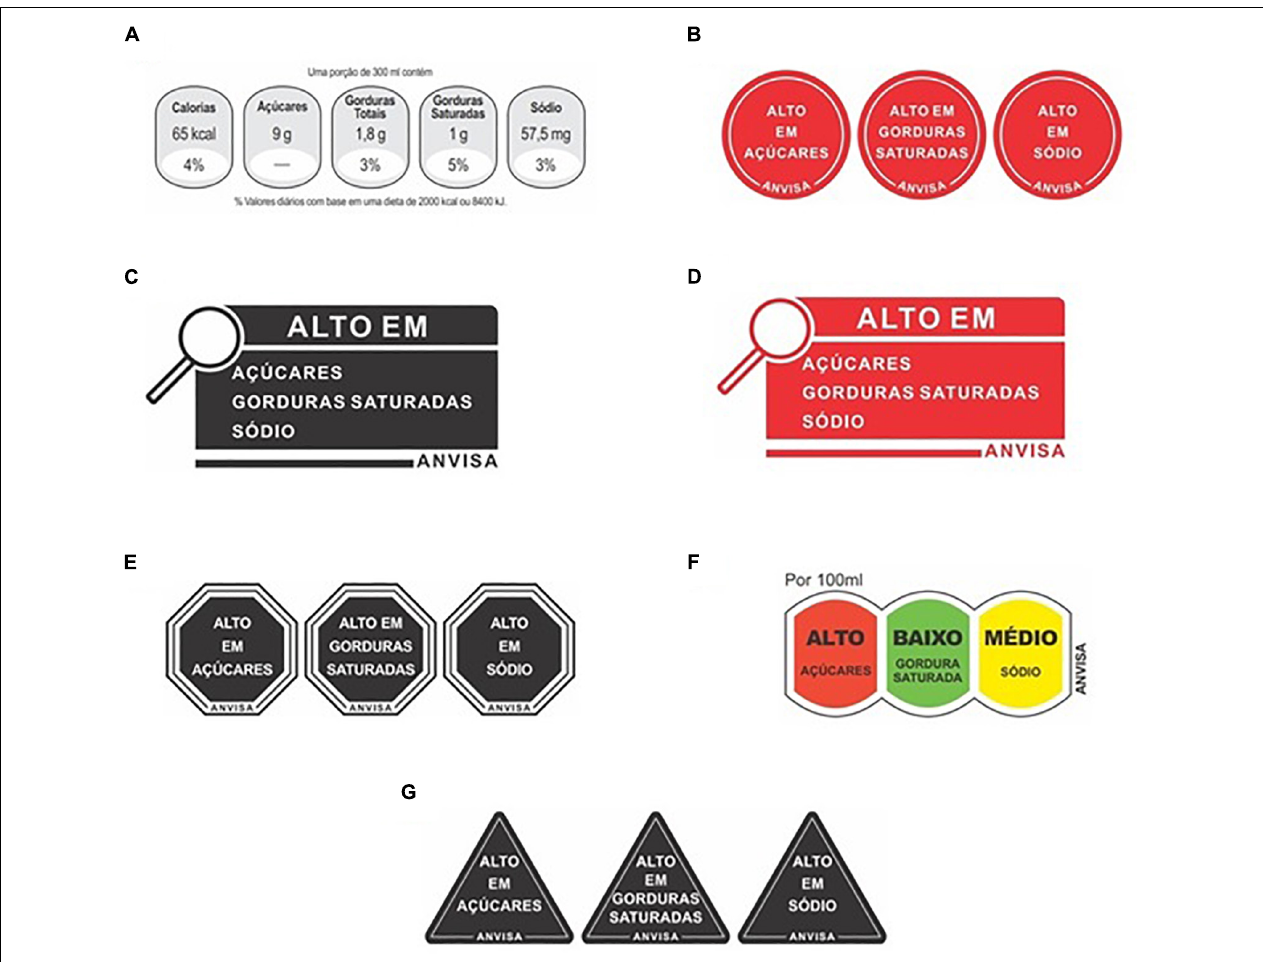
FIGURE 1 | Front-of-package nutrition labeling schemes considered in the study: (A) guidelines daily amounts (GDA) system, (B) red circle warning sign, (C) black magnifier warning sign, (D) red magnifier warning sign, (E) black octagon warning sign, (F) traffic-light system, (G) black triangle warning